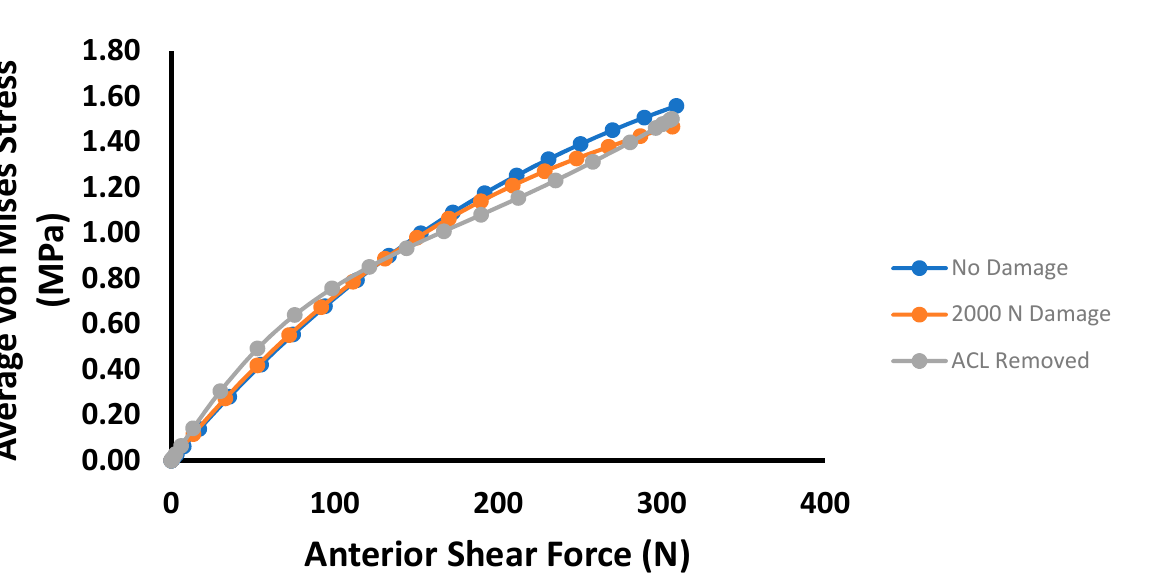
Figure 4. Plot of average MCL mid-substance von Mises stress (MPa) versus anterior shear force for the three prescribed damage cases.